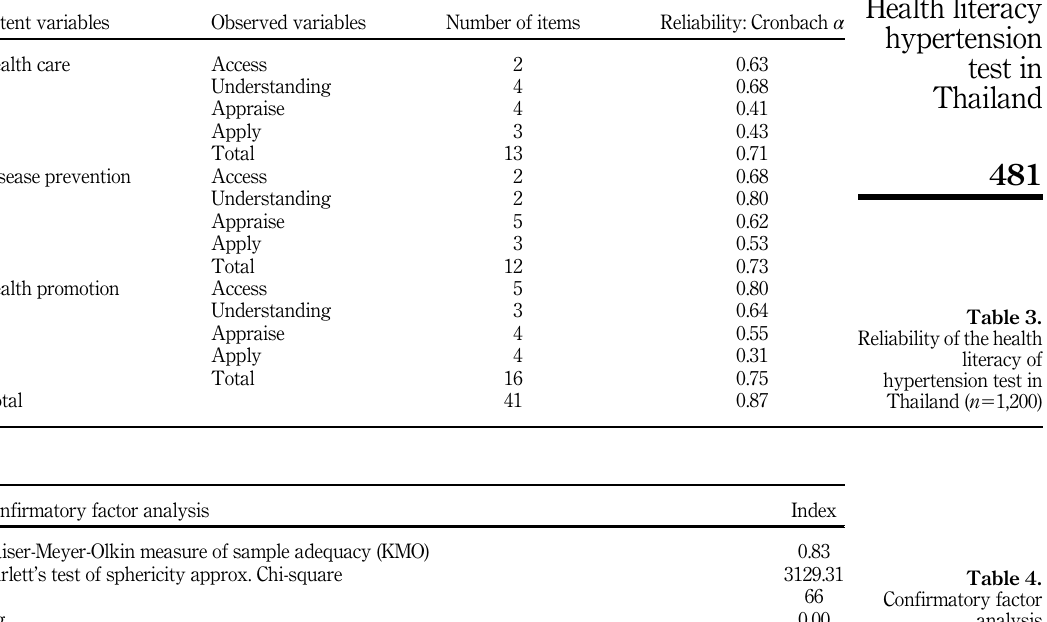
Table 4. Confirmatory